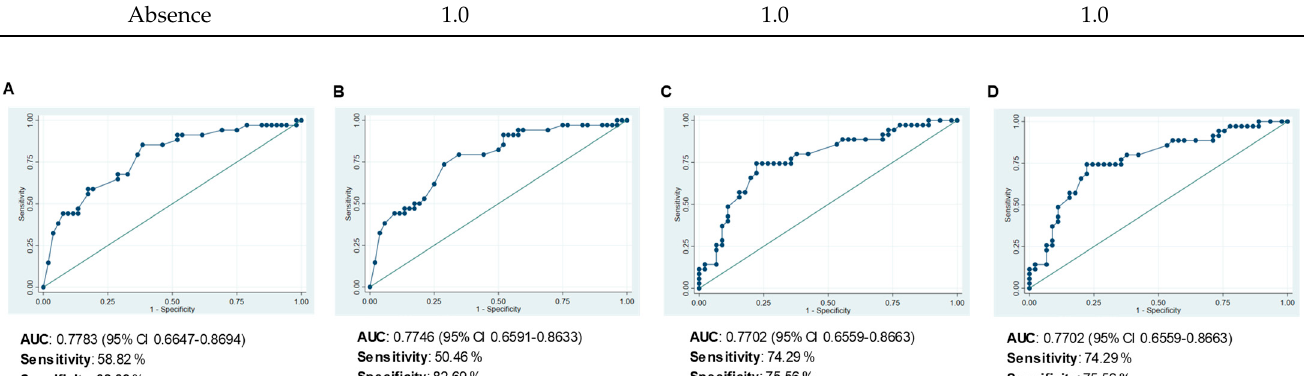
Figure 4. Receiver operating characteristic (ROC) curves evaluating the capacity of the final multivariate models to predict: ( A ) overall survival (OS), ( B ) OS after bootstrapping, ( C ) relapse-free survival (RFS), and ( D ) RFS after